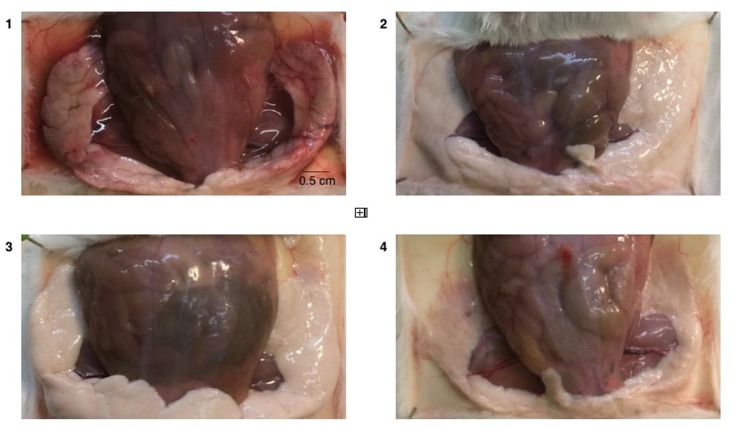
Gross pathology of mammary glands. Representative photographs from dissected mice are shown. Conditions are (1) PBS treatment (negative control group), (2) cefalonium treatment (positive control group), (3) bacteriophage cocktail treatment (phage treatment group), and (4) uninfected mice infused with the phage cocktail (safety control group). Macroscopic differences resulting from the different treatments of the infected mammary glands are clearly visible (e.g., prominent redness and inflammation in 1), and reflected in the scores in Figure 3.